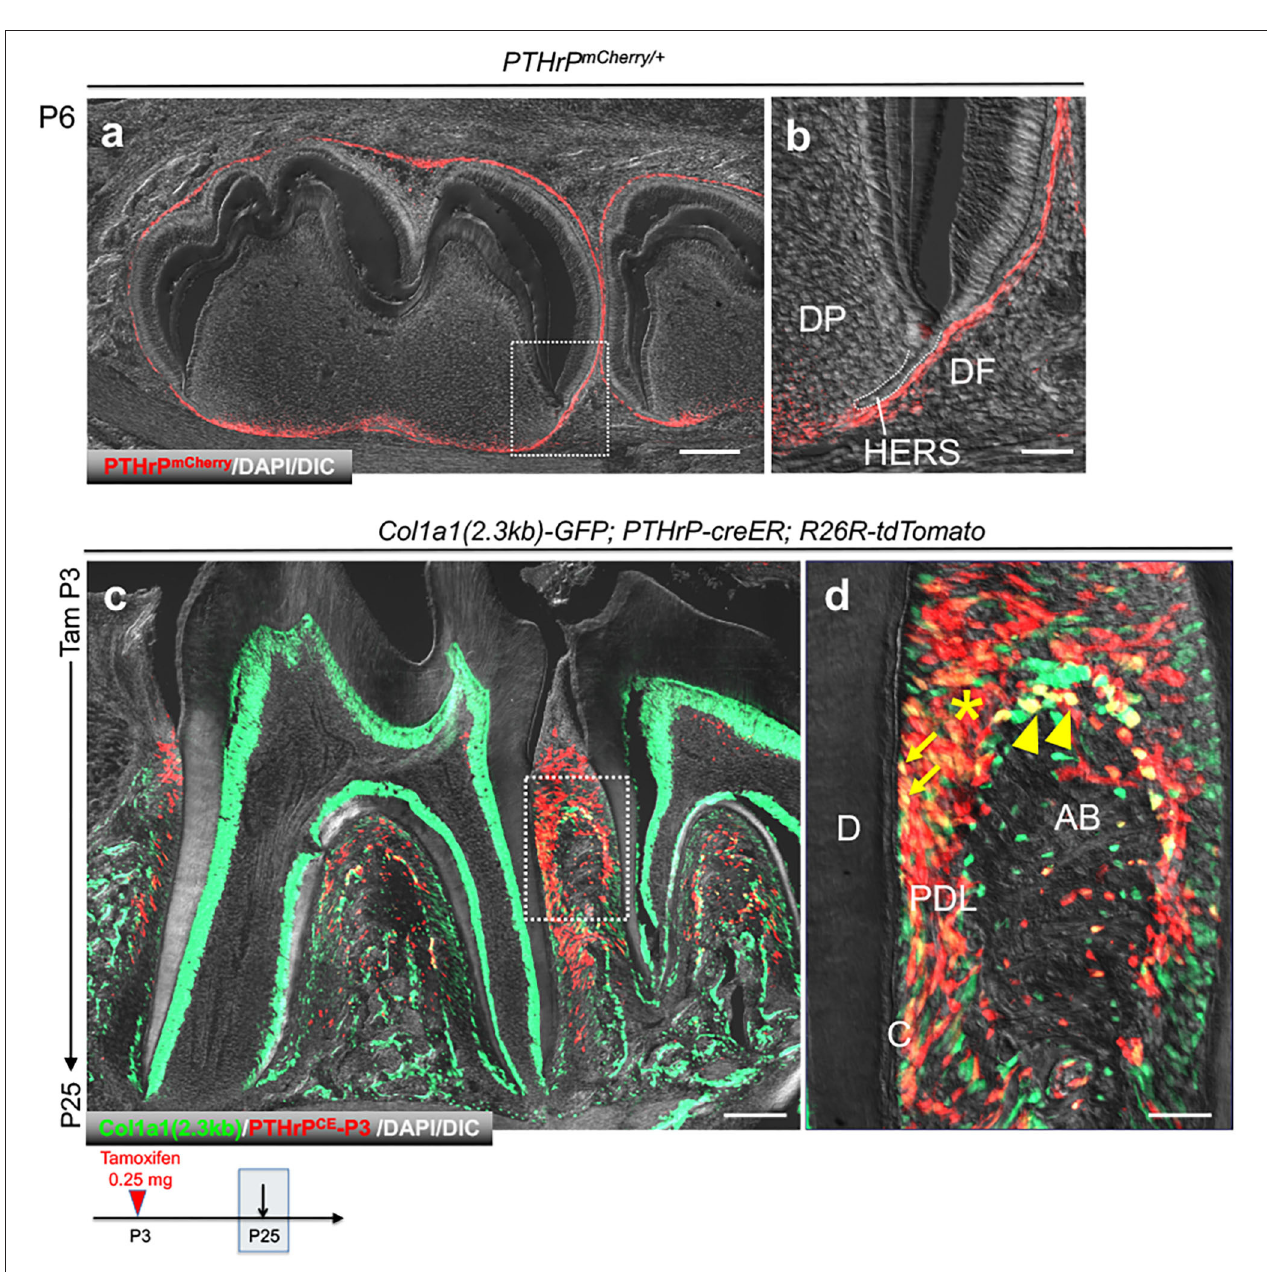
FIGURE 1 | PTHrP + DF mesenchymal progenitor cells differentiate into Col1a1-GFP + periodontal cells during tooth root development. (a,b) Mandibular tooth bud of PTHrP mCherry / + . DP: dental papilla, DF; dental follicle, HERS: Hertwig’s epithelial root sheath. (c,d) Mandibular molars of Col1a1(2.3kb) -GFP; PTHrP-creER;R26R- tdtomato. D: dentin, C: cementoblast, PDL: periodontal ligament, AB: alveolar bone. Arrow: Col1a1-GFP + tdTomato + cementoblasts on the root surface, Arrowhead: Col1a1-GFP + tdTomato + osteoblasts on the cryptal alveolar bone, *: Col1a1-GFP + tdTomato + PDL cells. Scale bars: 200 µ m (a,c) , 50 µ m (b,d) .